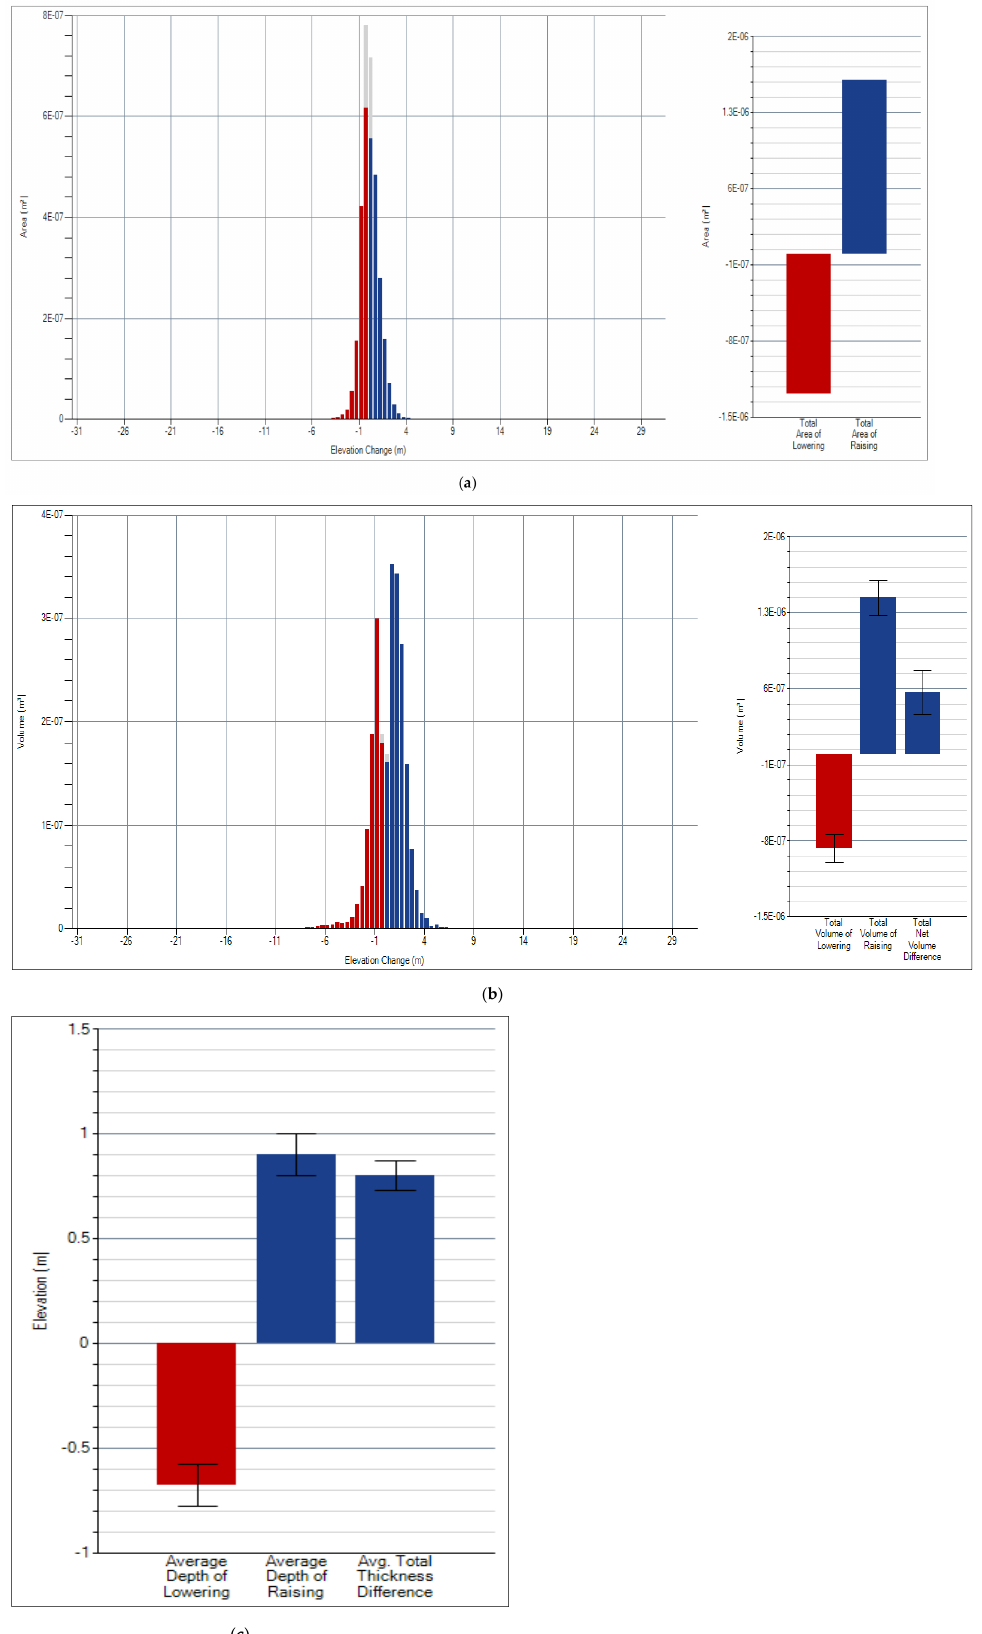
Figure A4. GCD result for ROI5.